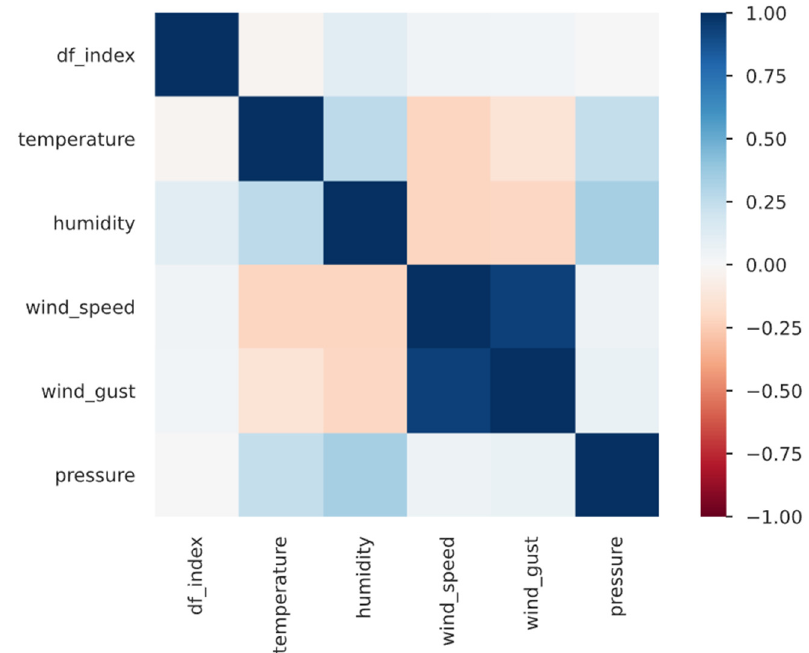
Figure 6. Correlation between weather features.